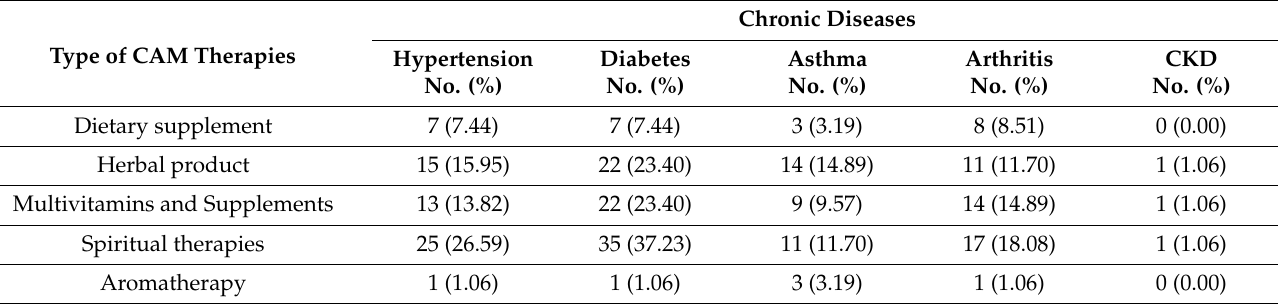
Table 3. Types of CAM used by CD